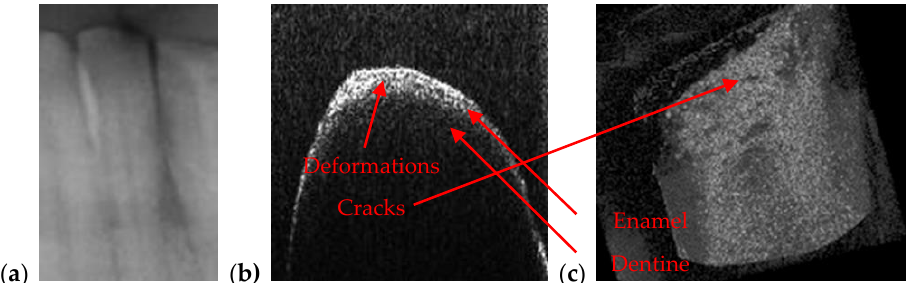
Figure 11. Enamel deformations of an incisive tooth from mandible that cannot be observed on a section cropped from a panoramic radiography ( a ) but can be clearly remarked both on ( b ) OCT B-scans and on ( c ) a 3D OCT reconstruction (performed on the tooth extracted for medical purposes after performing the radiography). Materials 2019 , 12 , x FOR PEER REVIEW Figure 12. Enamel deformations and cracks of an incisive tooth observed on ( a ) OCT 3D reconstruction, as well as on ( b , c ) different B-scans.